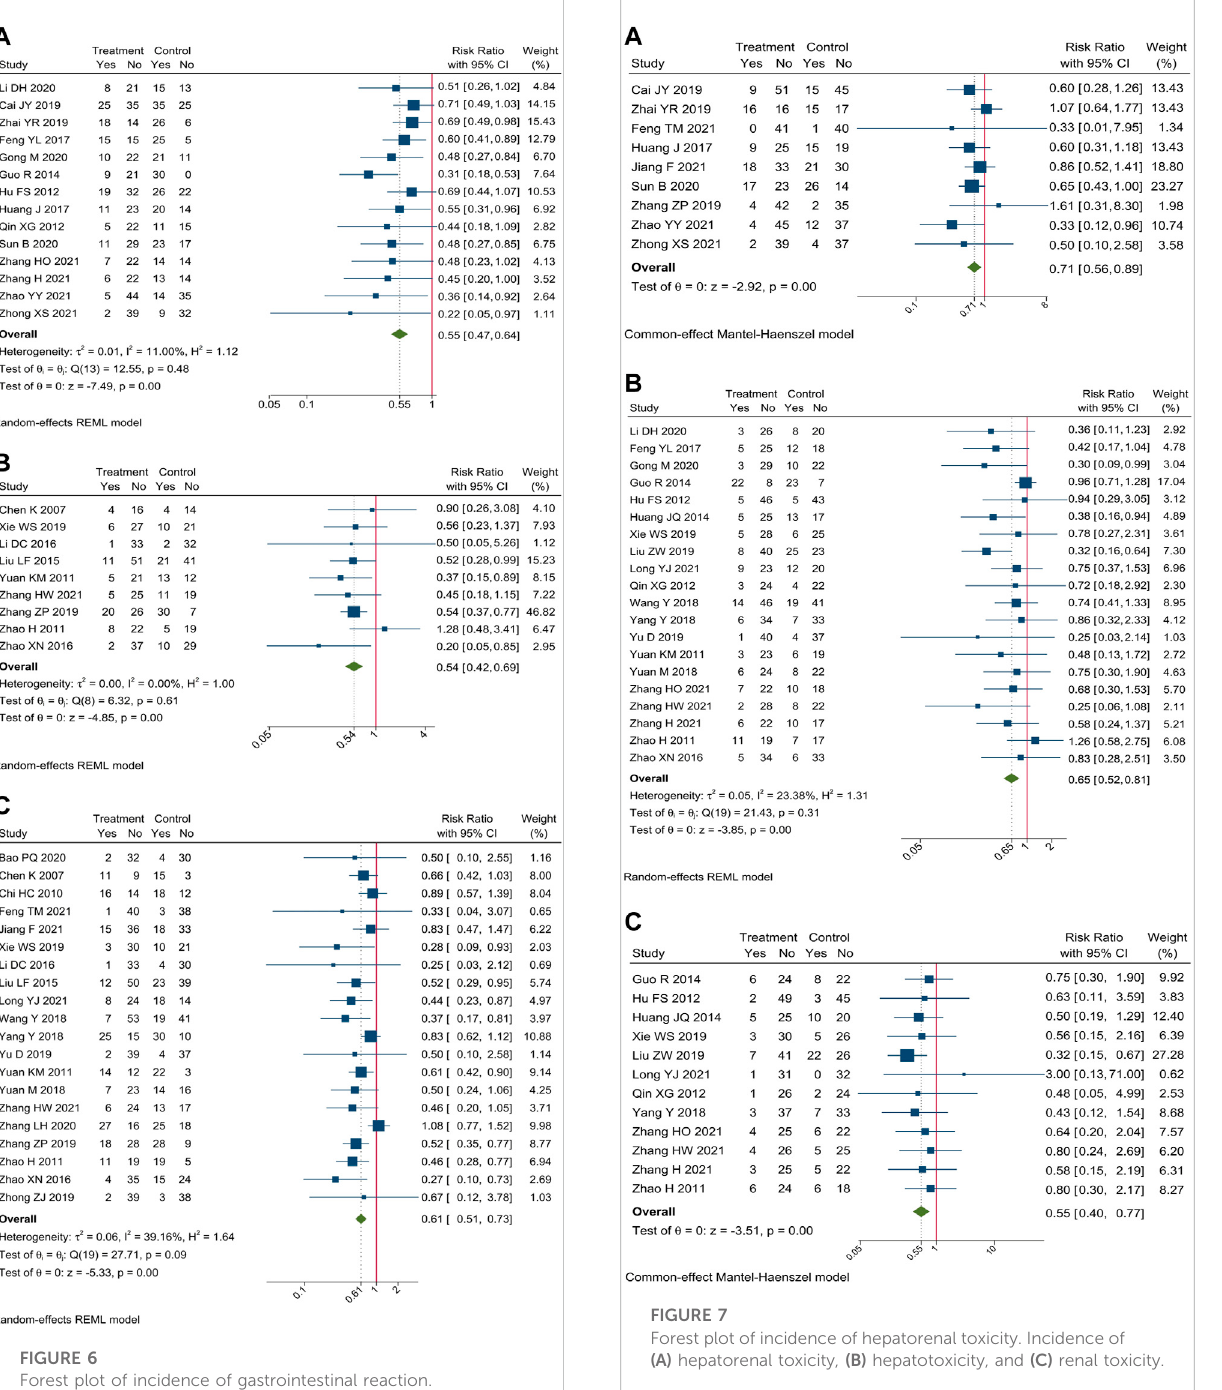
FIGURE 6 Forest plot of incidence of gastrointestinal reaction.